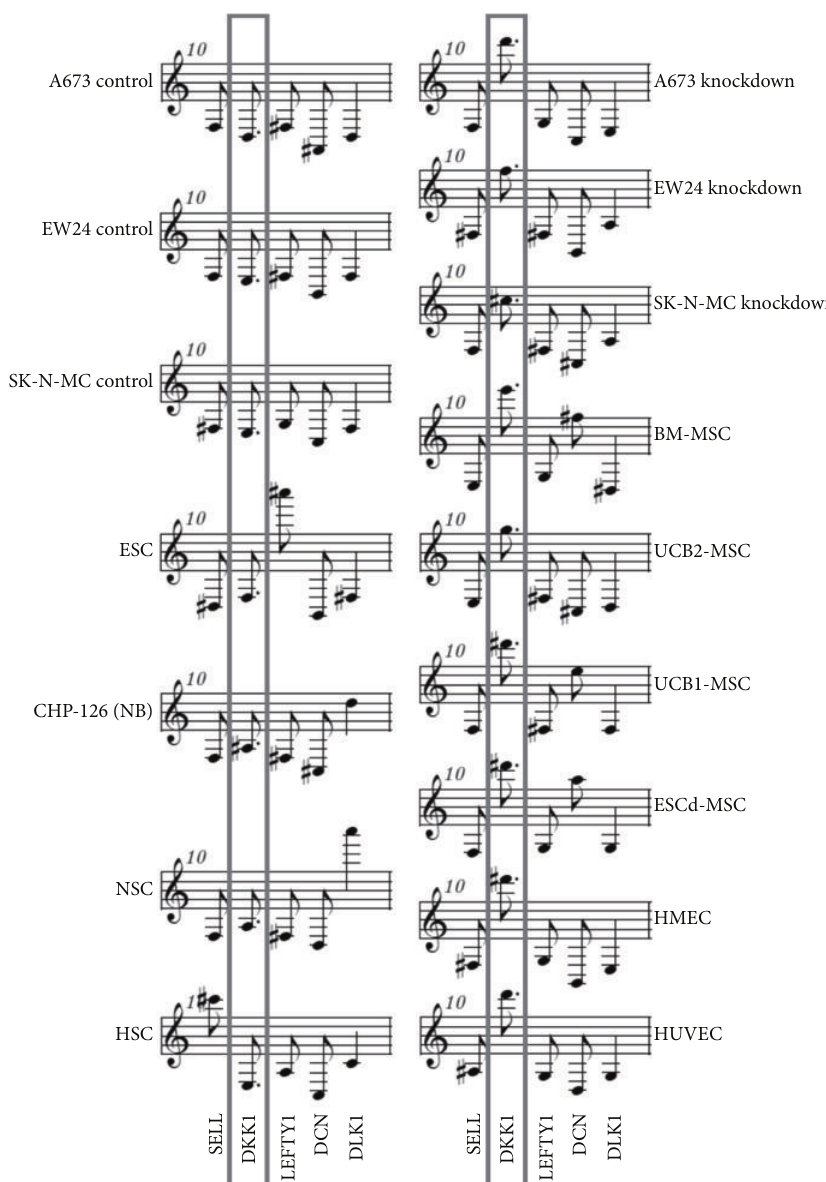
Figure 7: DKK1 expression discriminates between MSC/EC and other cell types. DNA microarray cel files were processed as described in the caption of Figure 5. Presented is the 10th bar from representative individual samples. The differentially expressed gene DKK1 is